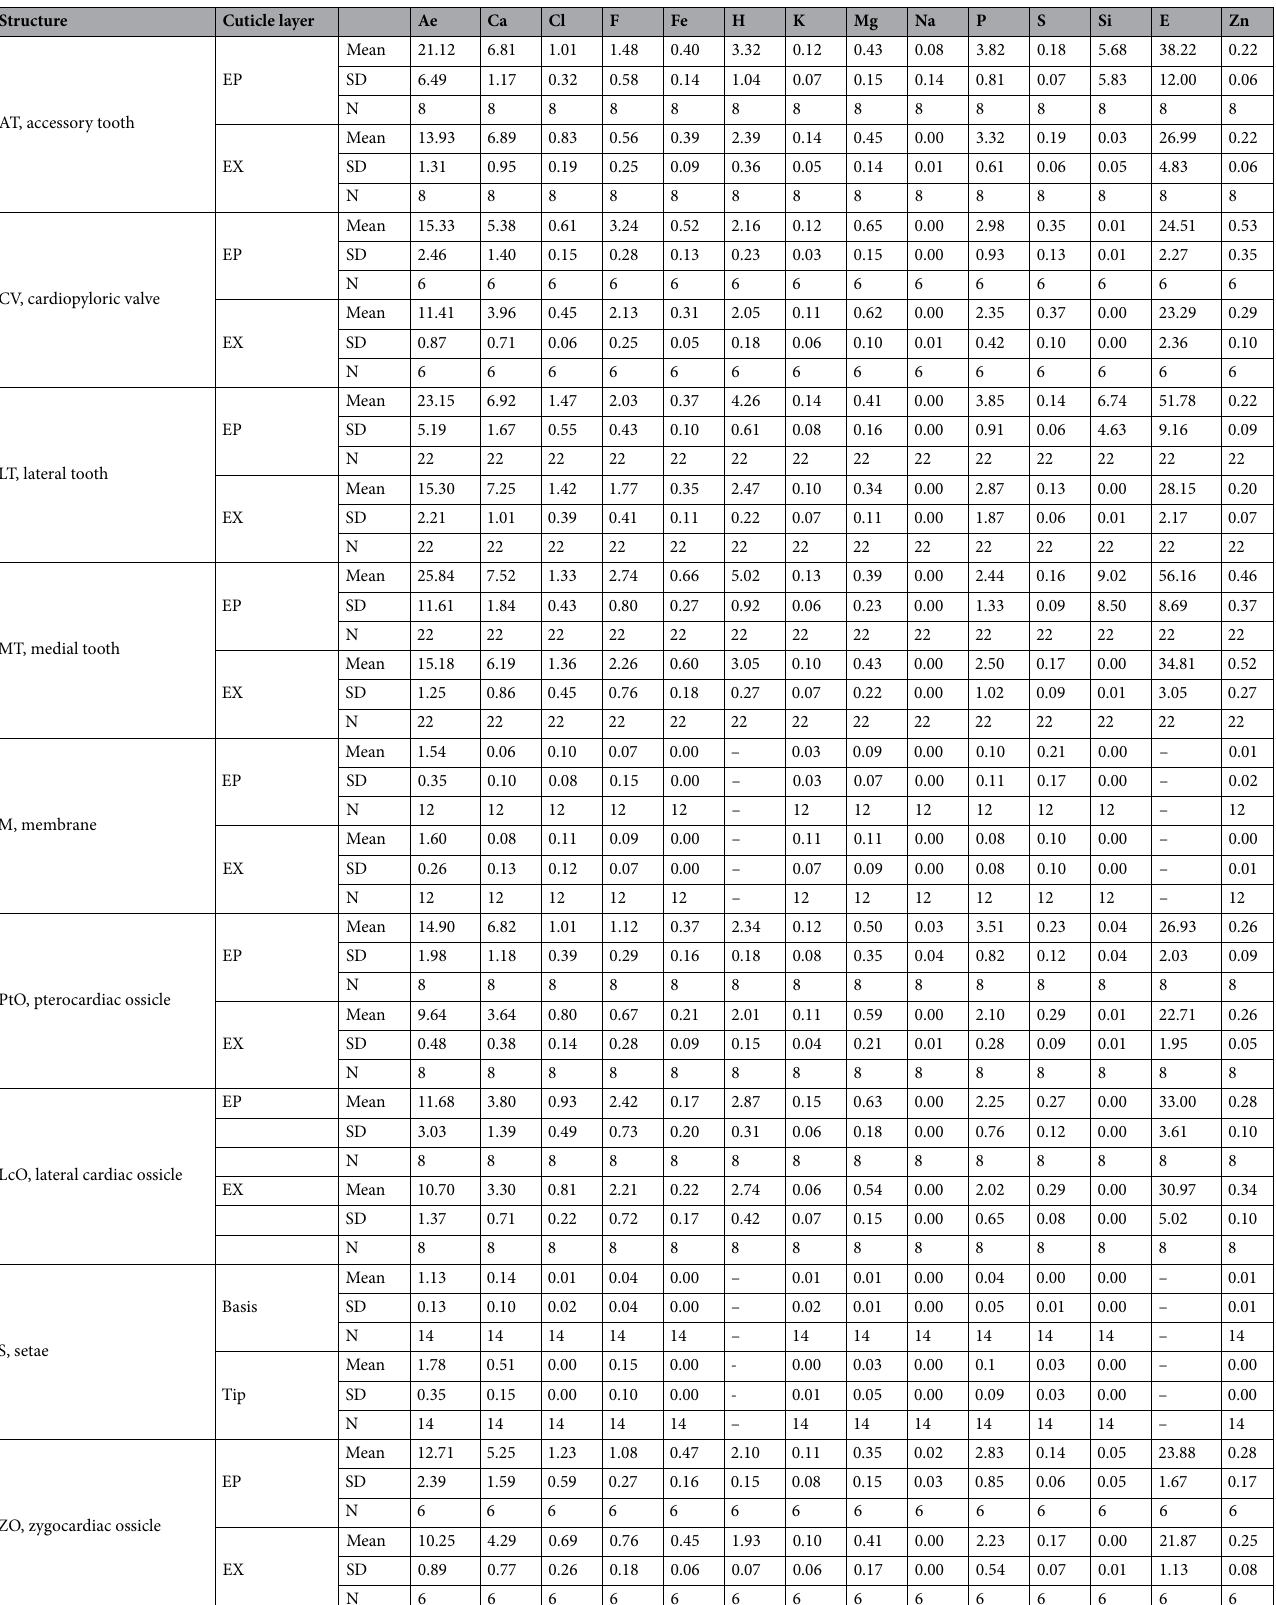
Table 1. The mean and SD of the mechanical properties (H and E both in GPa) and elemental proportions (in atomic %) for the epi- and exocuticle of each individual structure. E Young’s modulus, EP epicuticle, EX exocuticle, H hardness, N quantity of tests, SD standard